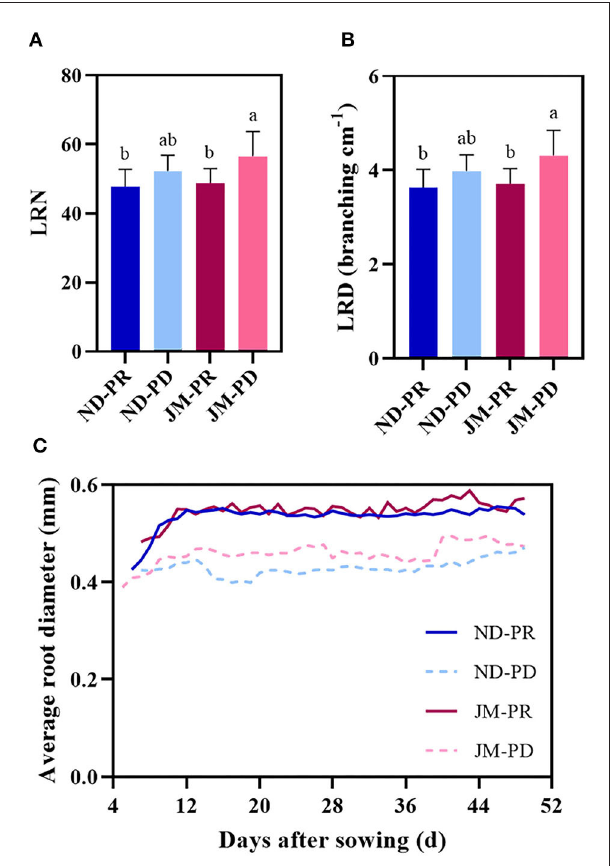
FIGURE 6 | Trends in the number of lateral roots (LRN) (A) , lateral root branching density (LRD) (B) , and average root diameter (AD) (C) of two cotton cultivars under different phosphorus levels. ND-PR, ‘Nongdamian No. 10” cultivar under replete phosphorus conditions; ND-PD, “Nongdamian No. 10” cultivar under low phosphorus; JM-PR, “Jimian 315” cultivar under replete phosphorus conditions; JM-PD, “Jimian 315” cultivar under low phosphorus. Depicted are the means of six replicates ± standard errors. For each trait, bars with the same letter are not significantly different according to Duncan’s test at a P < 0.05